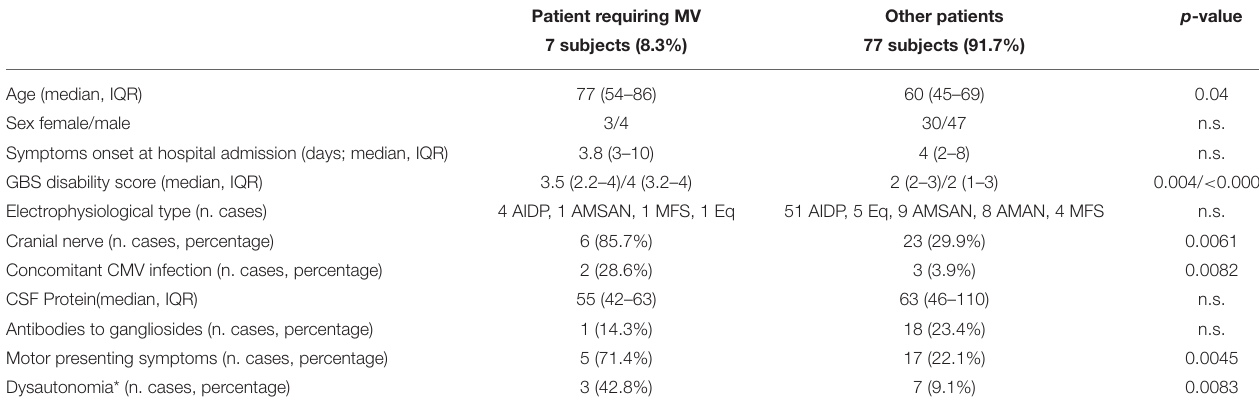
TABLE 3 | Comparison between patients requiring mechanical ventilation (MV) and the others GBS subjects.